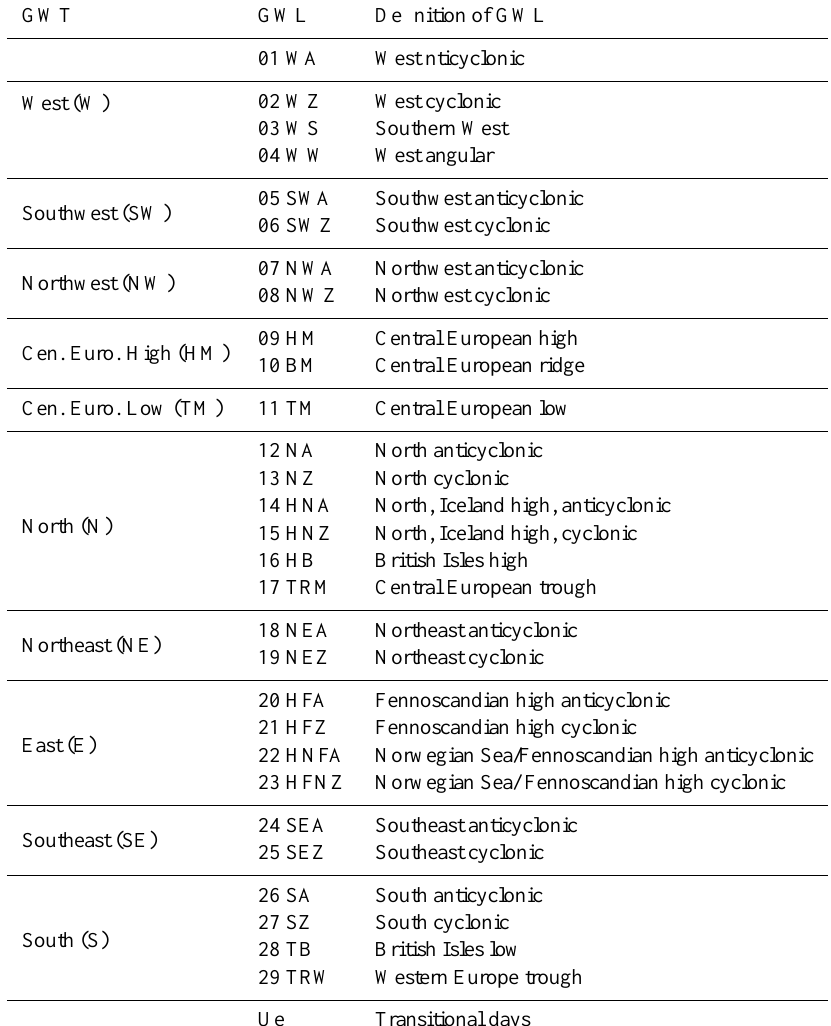
Table 3. GWT and GWL with definitions (Gerstengarbe, Werner, 2005).